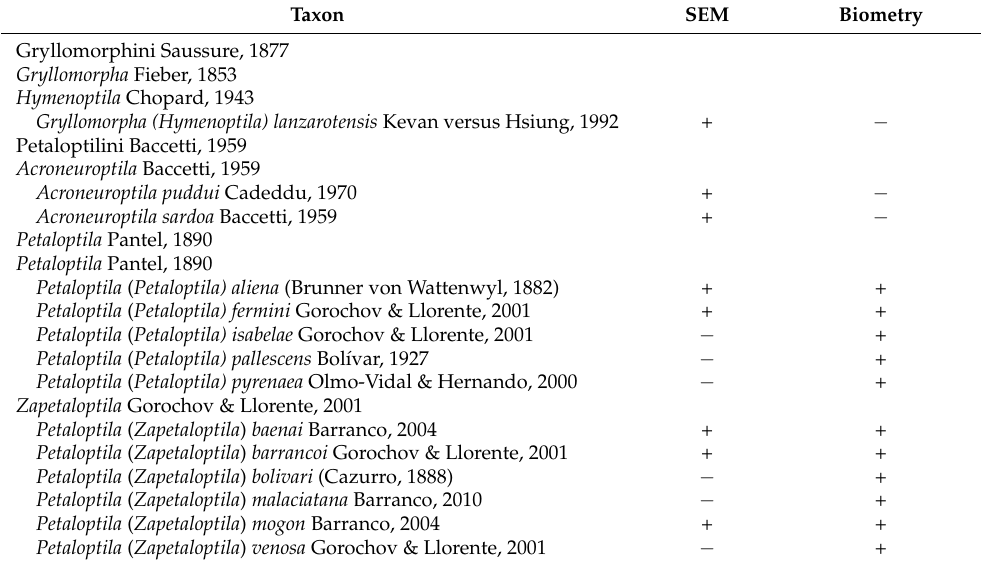
Table 1. Species included in this study. The table shows the species studied. Tribe, genus, and subgenus are indicated for Gryllomorpha and Petaloptila . In addition, (+) is indicated if the species have been analyzed by scanning electron microscope (SEM) images and/or by biometric measurements (Biometry). If not, ( − ) is also